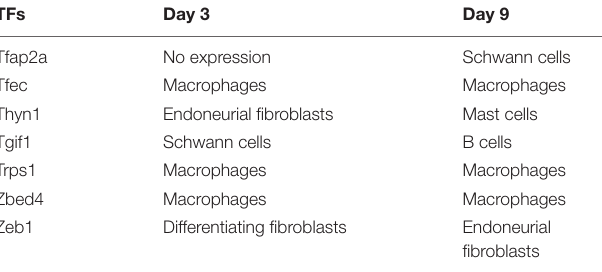
TABLE 2 | Cell types showing the highest level of